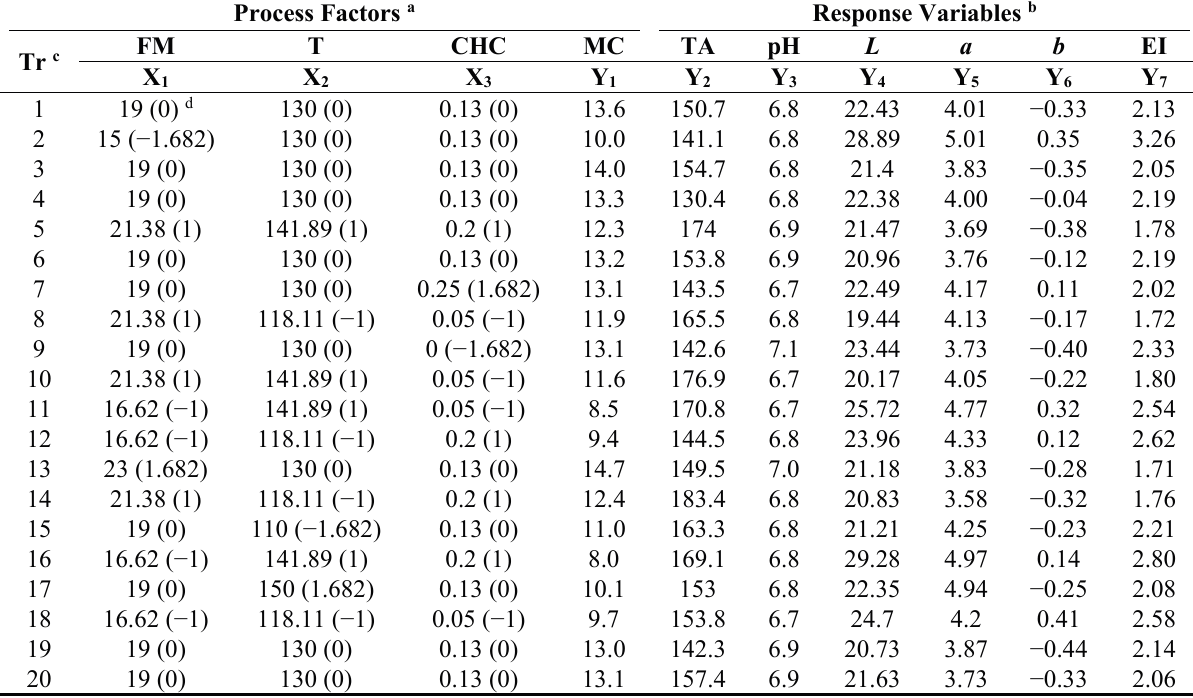
Table 2. Experiment design used to obtain different combinations of extrusion feed moisture/calcium hydroxide concentration/temperature for production of expanded nixtamalized blue corn